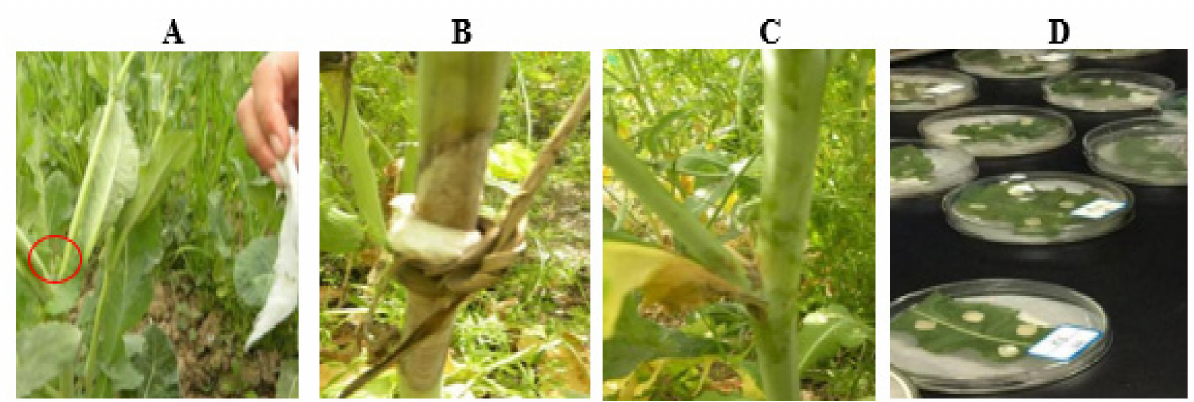
Figure 1. Toothpicks inoculation (red circle). ( A ) Toothpicks inoculation. ( B ) Symptoms of Sclerotinia sclerotiorum stem rot (14 d after inoculation) on stems of susceptible cultivars inoculated with the toothpicks method. ( C ) Symptoms of Sclerotinia sclerotiorum stem rot (14 d after inoculation) on stems of resistant cultivars inoculated with the toothpicks method. ( D ) Inoculation on detached leaves.